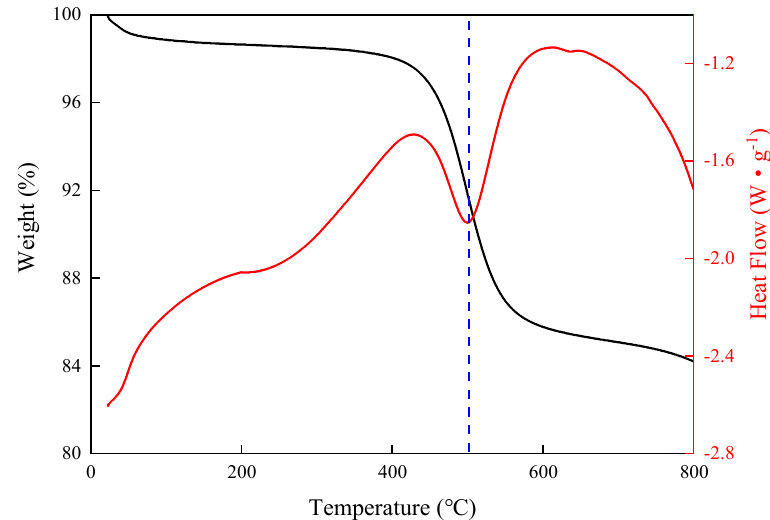
Figure 1. TG/DSC in the kaolinite − metakaolin transition region.